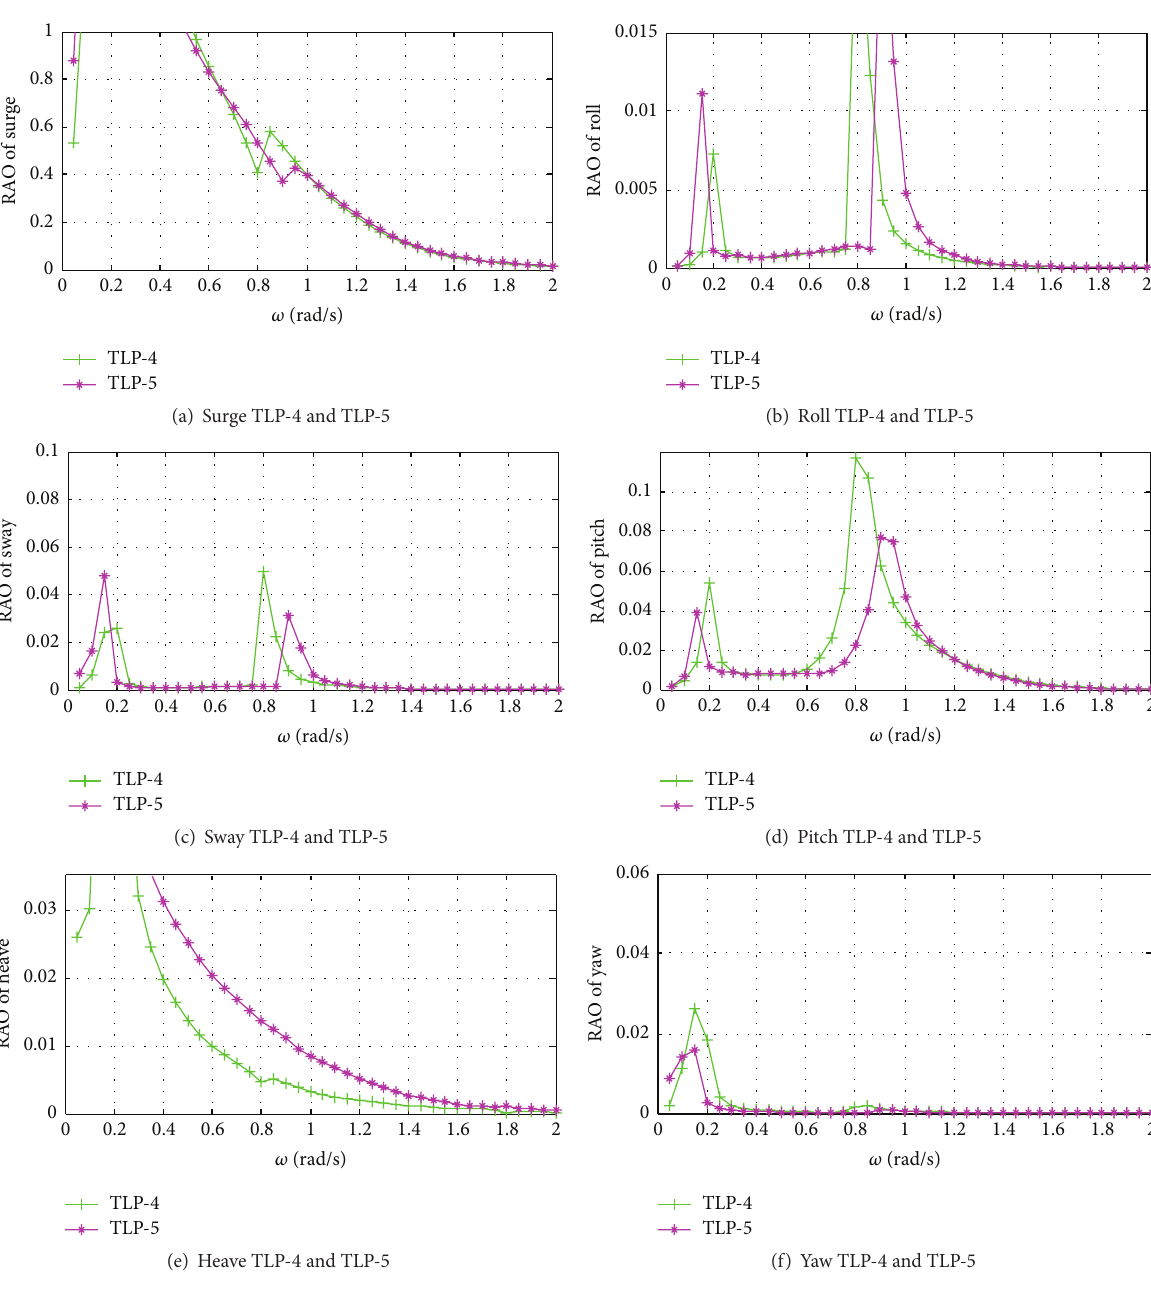
Figure 10: TLP-5 and TLP-4